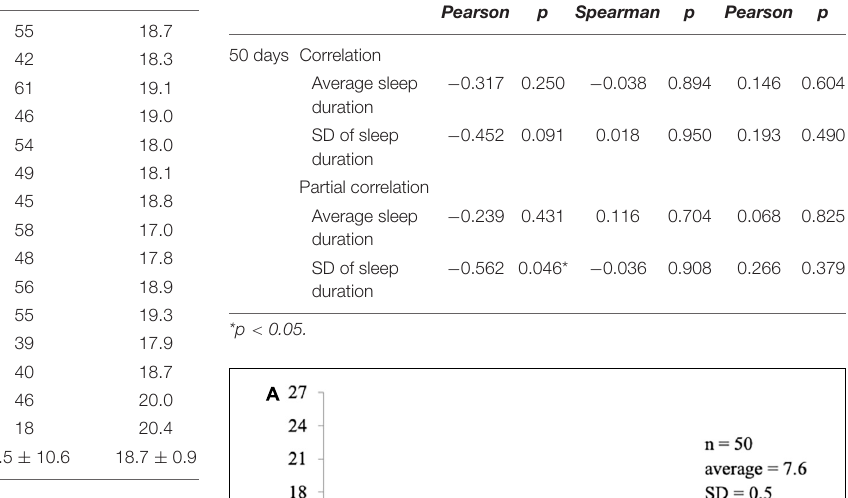
TABLE 2 | Correlations and partial correlation (after controlled soft tennis experience and sex) of Sleep Index and athletic performance. Sleep diary